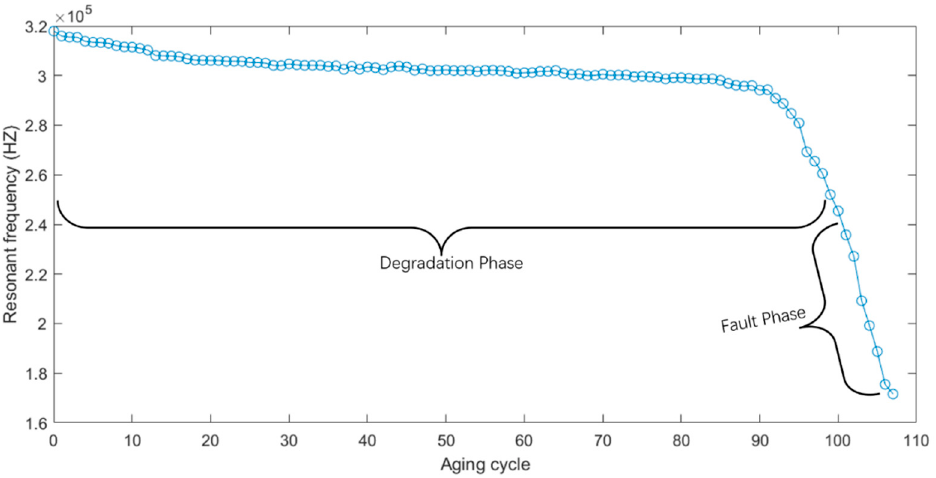
Figure 8. Degradation trend of resonant frequency of the electromagnetic coil. The health indicator ( HI ), which is homogenized based on resonant frequency, is in- troduced to indicate the degree of insulation degradation of the electromagnetic coil, as shown in formula (1). Therefore, HI is equal to 0.45, which is the failure threshold of the electromagnetic coil.